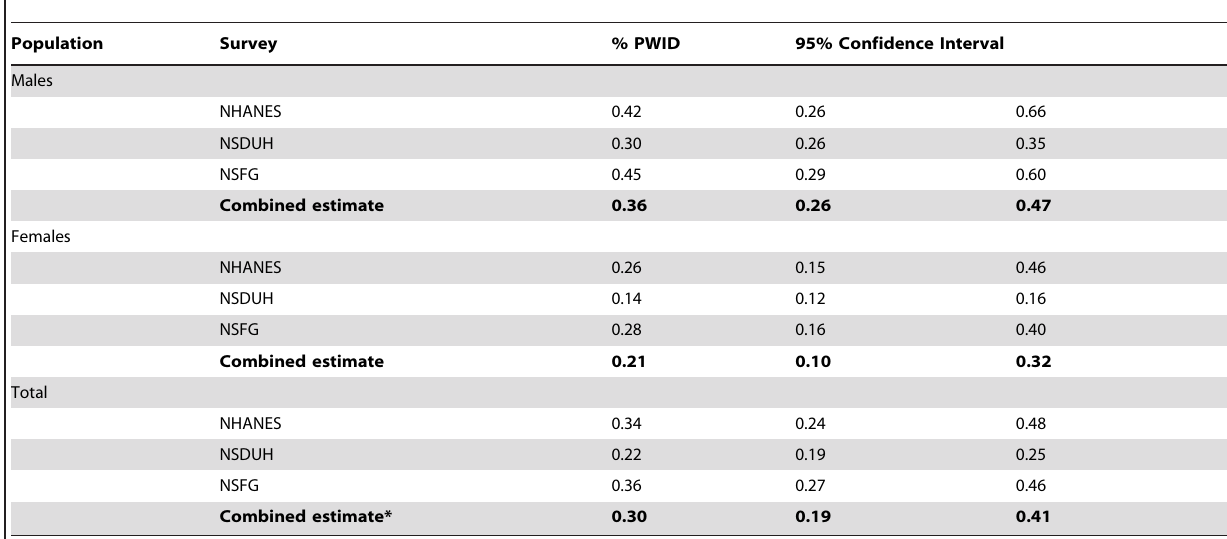
Table 3. Estimated proportion of persons who injected drugs (PWID) in the past year, by survey and combined by meta-analysis, United